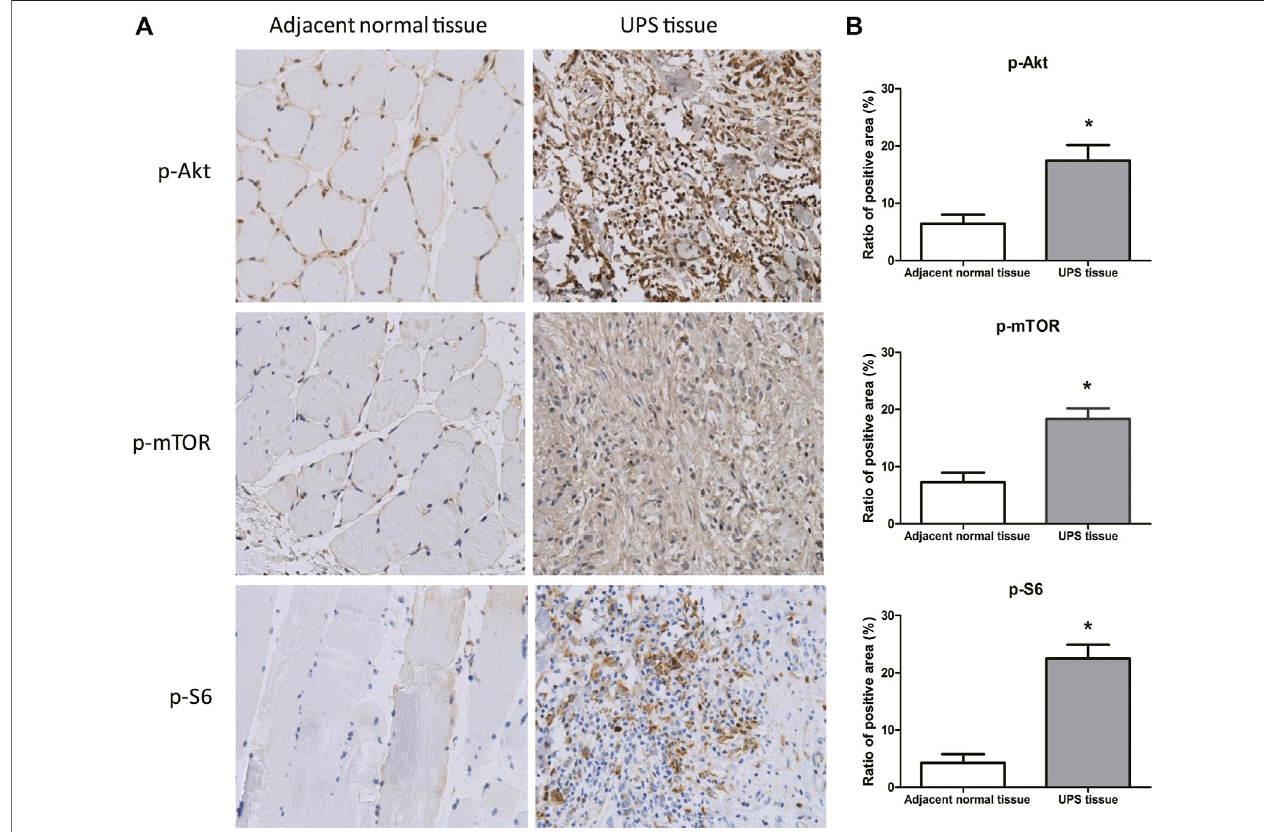
FIGURE 2 | Protein expression of p-Akt, p-mTOR, and p-S6 in the UPS sarcoma tissue and adjacent normal tissue. (A) : Representative images of the protein expressionofp-Akt,p-mTOR,andp-S6intheUPSsarcomatissueandadjacentnormaltissuebyimmunohistochemistry(200×); (B) :Thecomparisonoftheratiosofthe positive area to the total area of p-Akt, p-mTOR, and p-S6 between the UPS sarcoma tissue and adjacent normal tissue. *: vs. adjacent normal tissue, p <